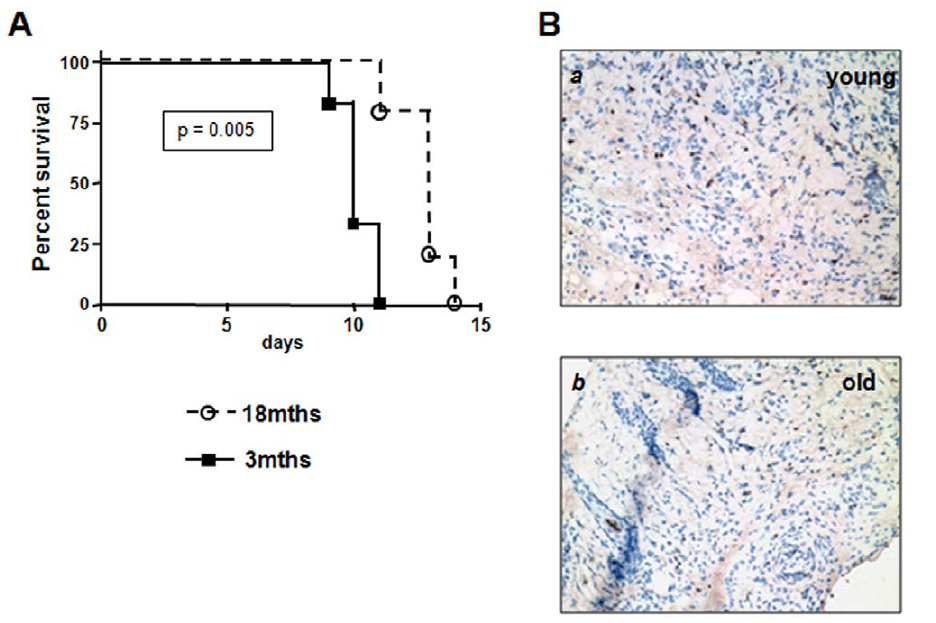
Figure 3. Recipient age prolongs skin allograft survival in WT mice. Recipient age prolongs skin allograft survival in WT mice ( A ), (p , 0.005) and is associated with reduced intragraft CD4 + T-cell infiltrates ( B ) (day 7, 200 6 ).